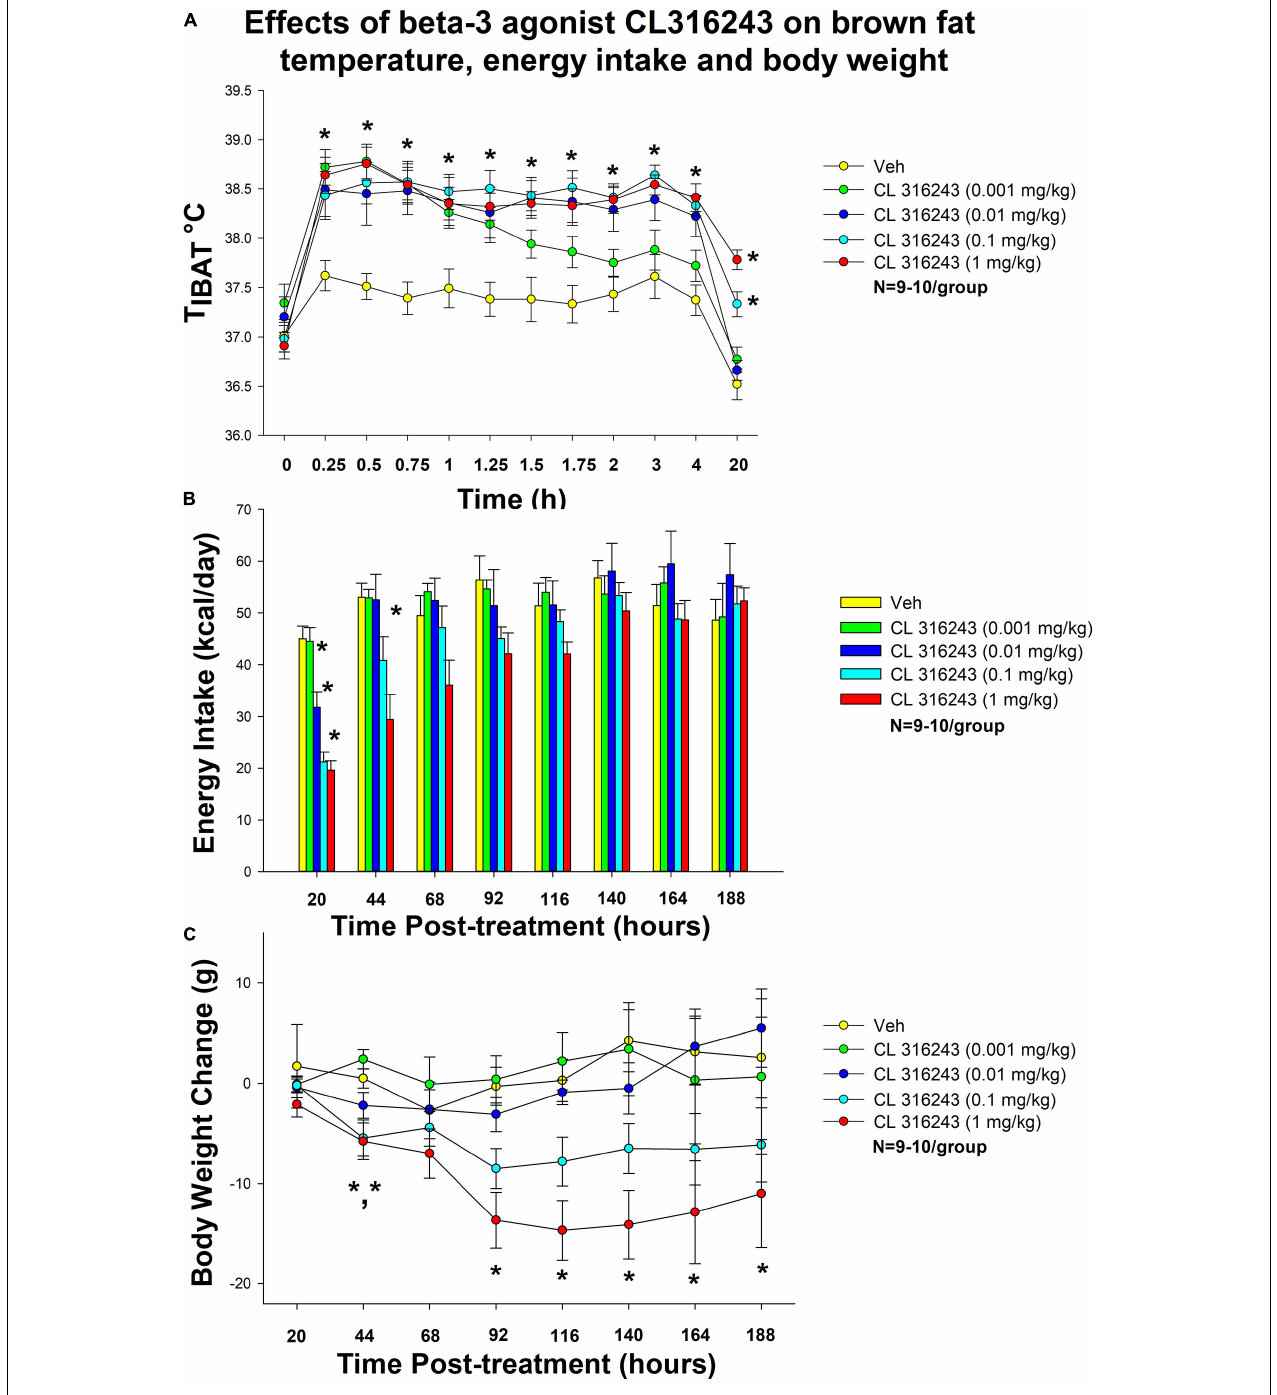
FIGURE 1 | Dose-response effects of the beta-3 receptor agonist, CL 316243, on body weight, food intake, and T IBAT in male DIO rats. Ad libitum fed rats were either maintained on HFD (60% kcal from fat; N = 9–10/group) for approximately 5.5 months prior to receiving IP injections of CL 316243 (0.001–1 mg/kg) or vehicle (sterile water) where each animal received each treatment 1 × every 8 days. (A) Effect of CL 316243 on T IBAT in DIO rats. (B) Effect of CL 316243 on energy intake (kcal/day) in DIO rats. (C) Effect of CL 316243 on change in body weight in HFD-fed DIO rats. Data are expressed as mean_SEM. * P < 0.05, (A) CL 316243 (0.01–1 mg/kg) vs. vehicle on T IBAT at 0.25, 0.5, 0.75, 1, 1.25, 1.5, 1.75, 2, 3, 4, and 20-h post-injection and CL 316243 (0.001 mg/kg) vs. vehicle on T IBAT at 0.25, 0.5, 0.75, 1, 1.25, and 1.5-h post-injection. CL 316243 (0.1 and 1 mg/kg) vs. vehicle on T IBAT at 20-h post-injection. * P < 0.05, (C) CL 316243 (0.1 and 1 mg/kg) vs. vehicle on body weight change at 44-h post-injection and CL 316243 (1 mg/kg) vs. vehicle on body weight change at 92-, 116-, 140-, 164-, and 188-h post-injection.